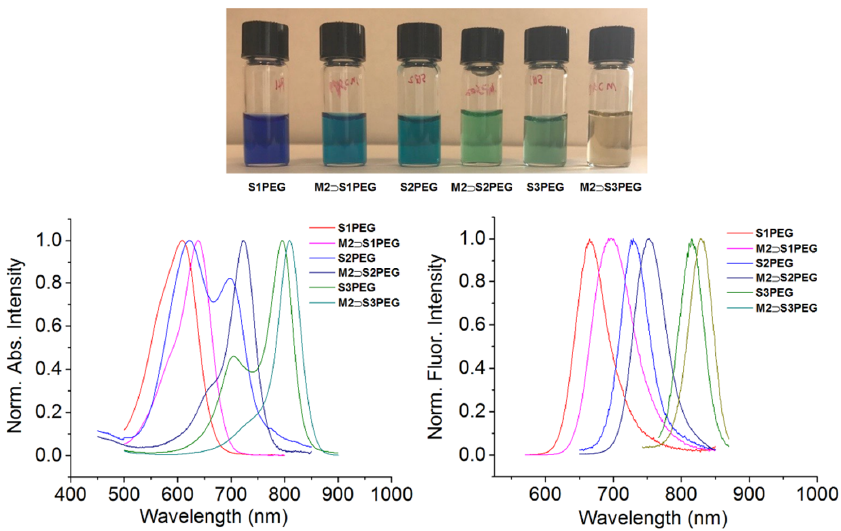
Figure 4. ( top ) Photograph of separate solutions containing free squaraine or macrocycle complex in H 2 O. Absorption ( bottom left ) and emission ( bottom right ) maxima for separate solutions containing squaraine or macrocycle complex in water.